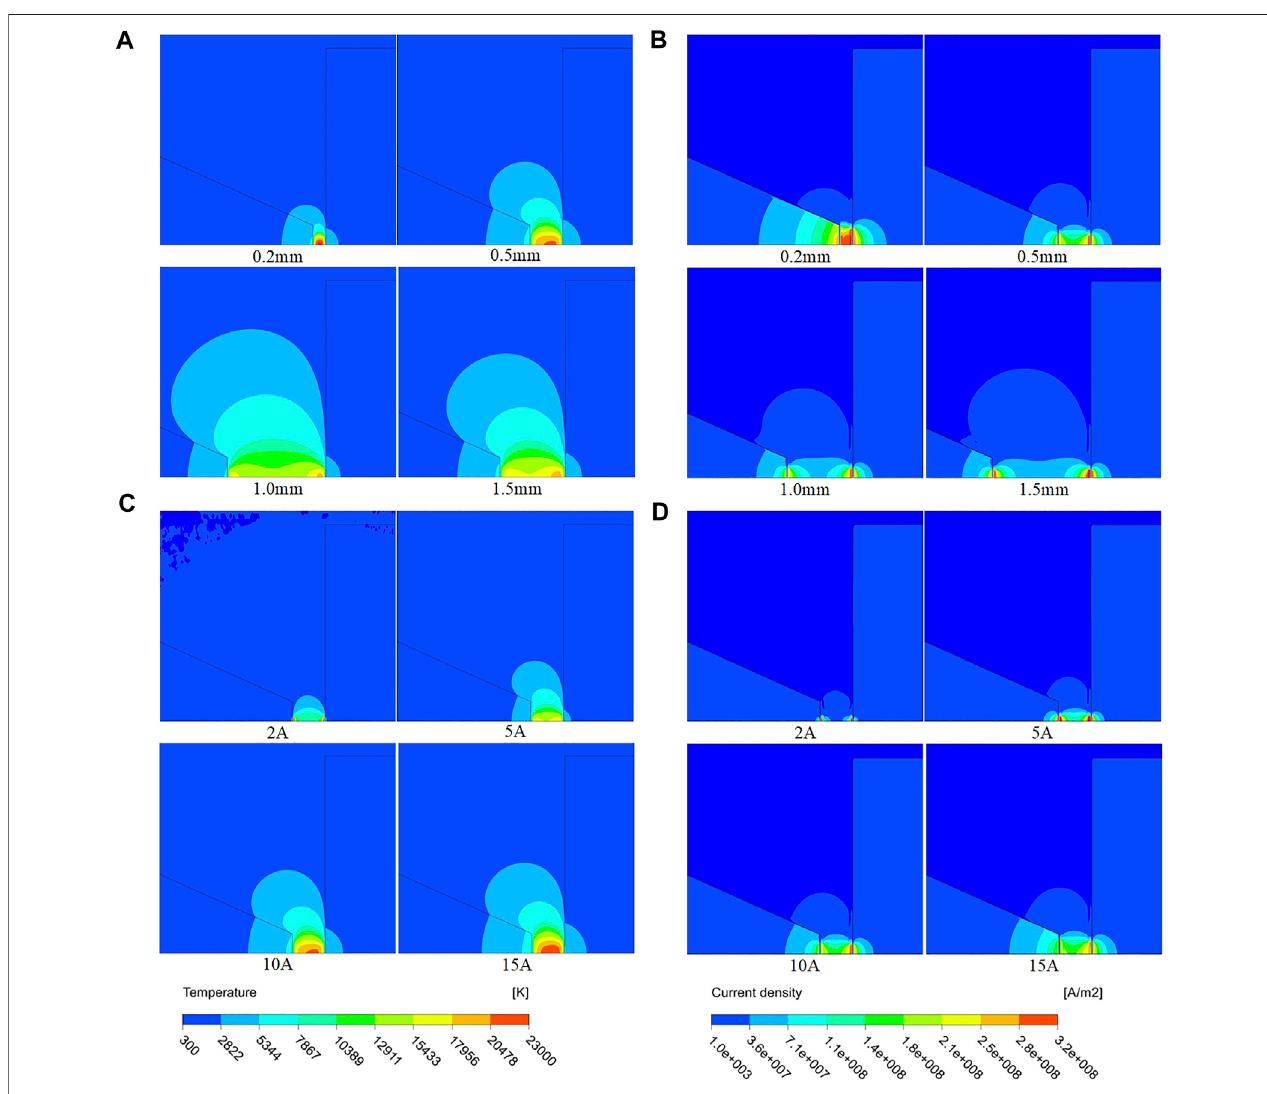
FIGURE5 | Arc temperature and current density under different lengths. (A) Arctemperature under different lengths, (B) arccurrent density under different length, (C) arc temperature under different currents, and (D) arc current density under different currents.